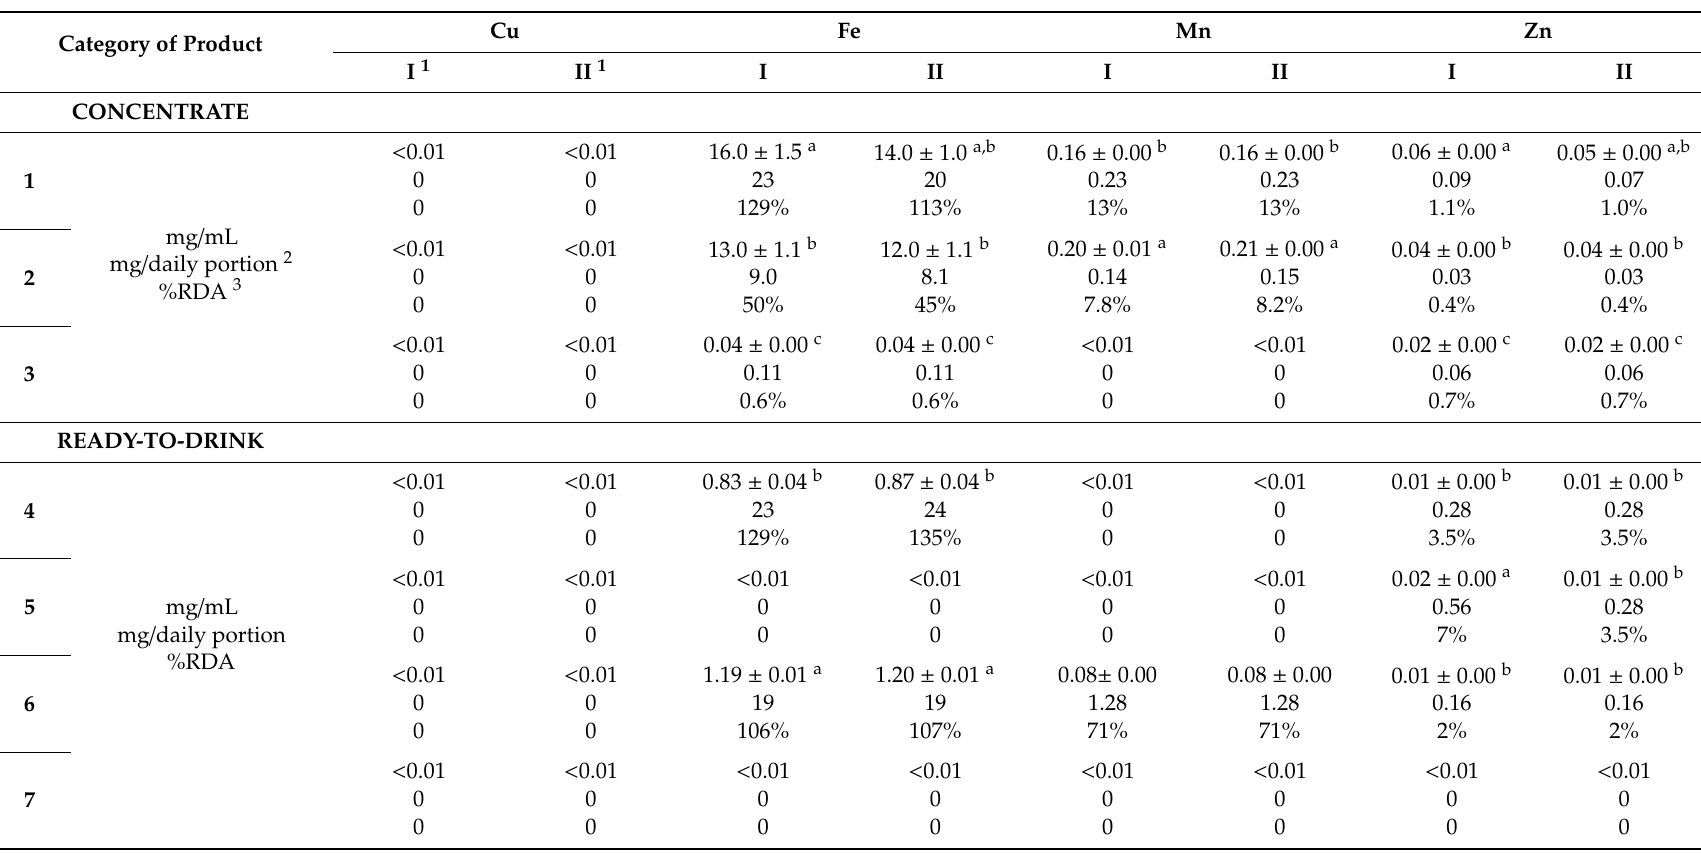
Table 2. The content of microelements in fulvic acid